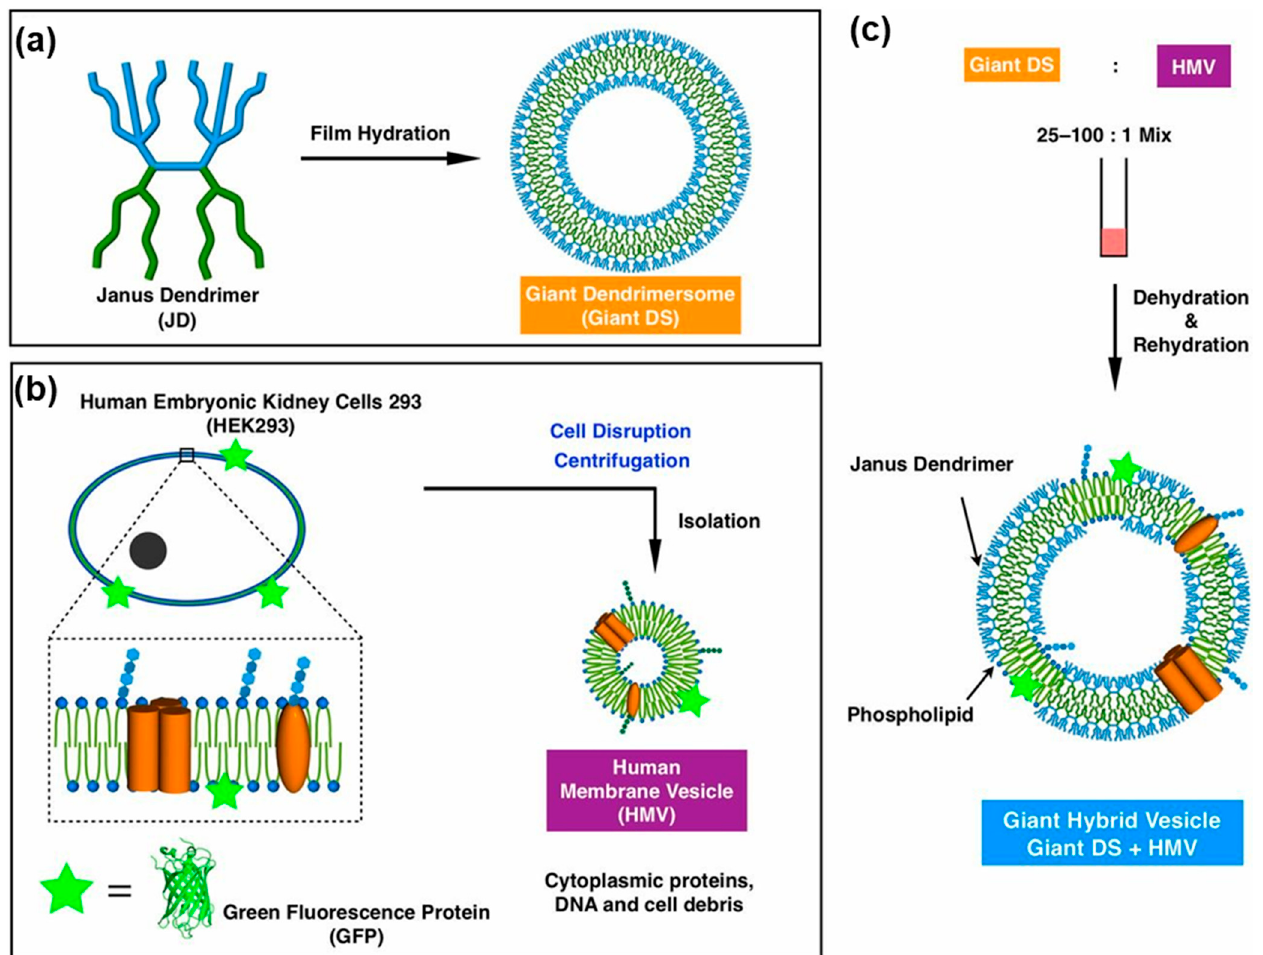
Figure 24. Schematic illustration of ( a ) the preparation of giant DSs, ( b ) the preparation of HMV from human kidney cells 293 (HEK293), and ( c ) coassembly of giant hybrid vesicles from giant DSs, and HMV from HEK293 labeled with GFP [218]. Copyright (2019) National Academy of Sciences USA. Encapsulation of Bacteria into